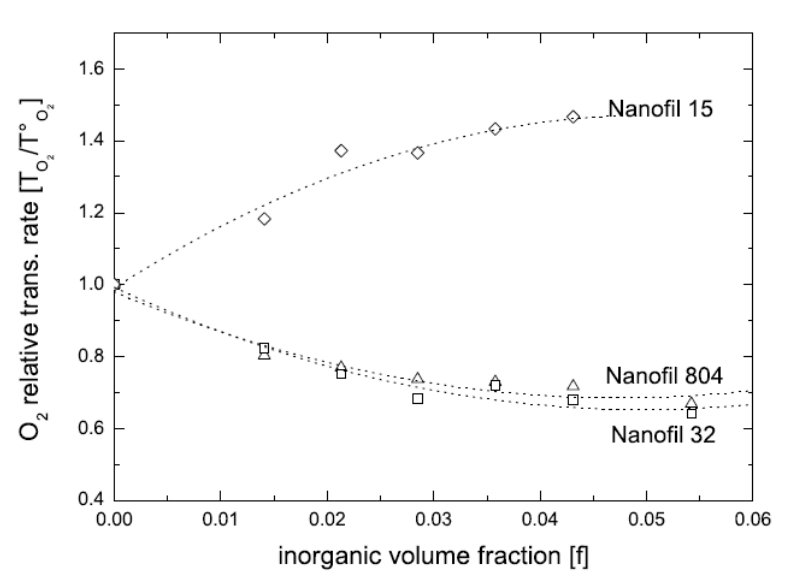
Figure 39. Oxygen permeation through the polyurethane nanocomposites as a function of filler volume fraction. Reproduced from reference [87] with permission from The American Chemical Society.